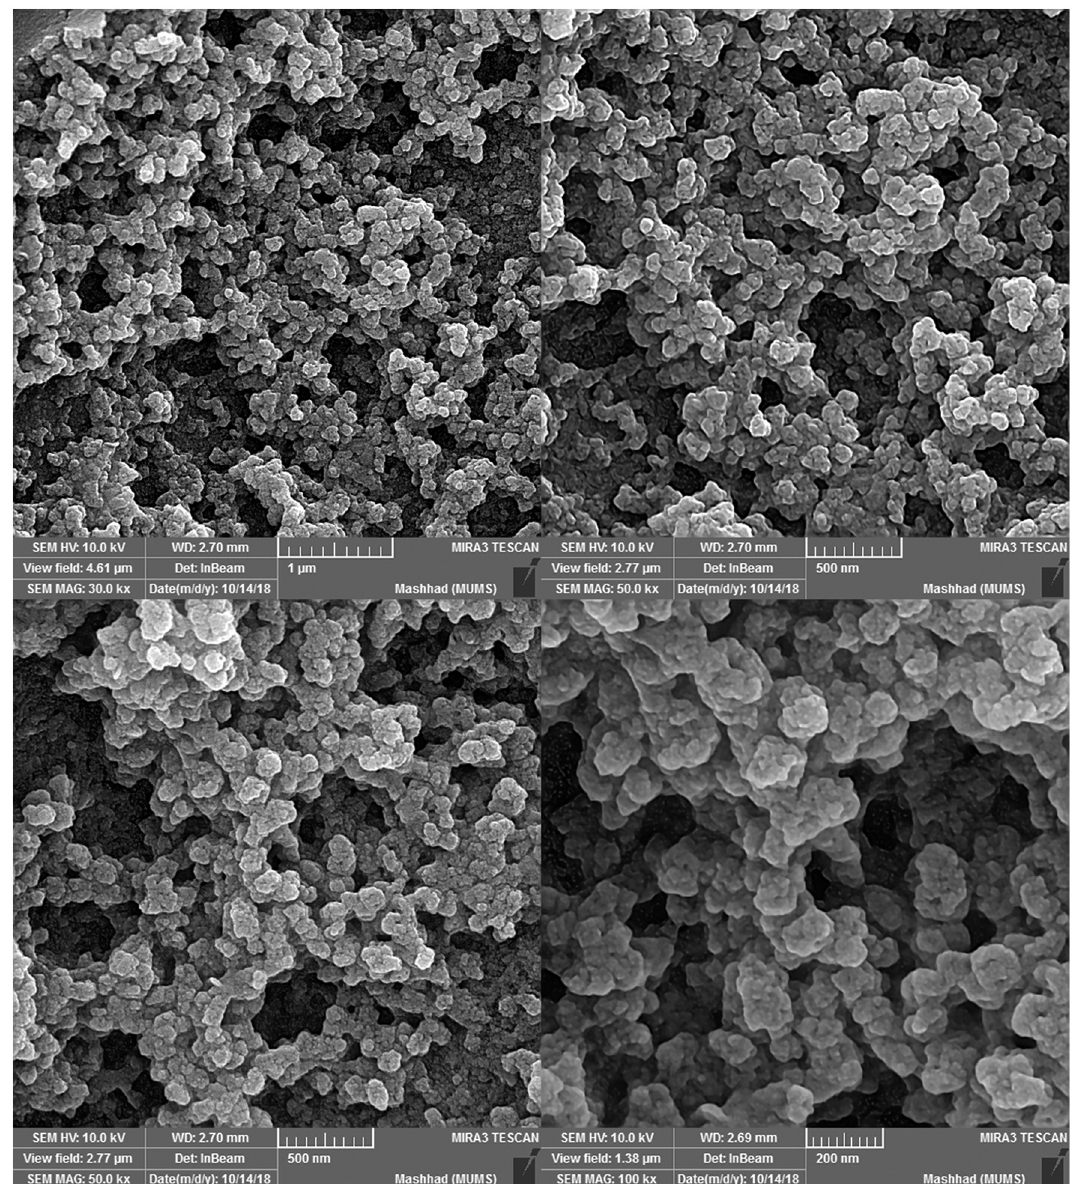
Figure 10: SEM images of SrTiO